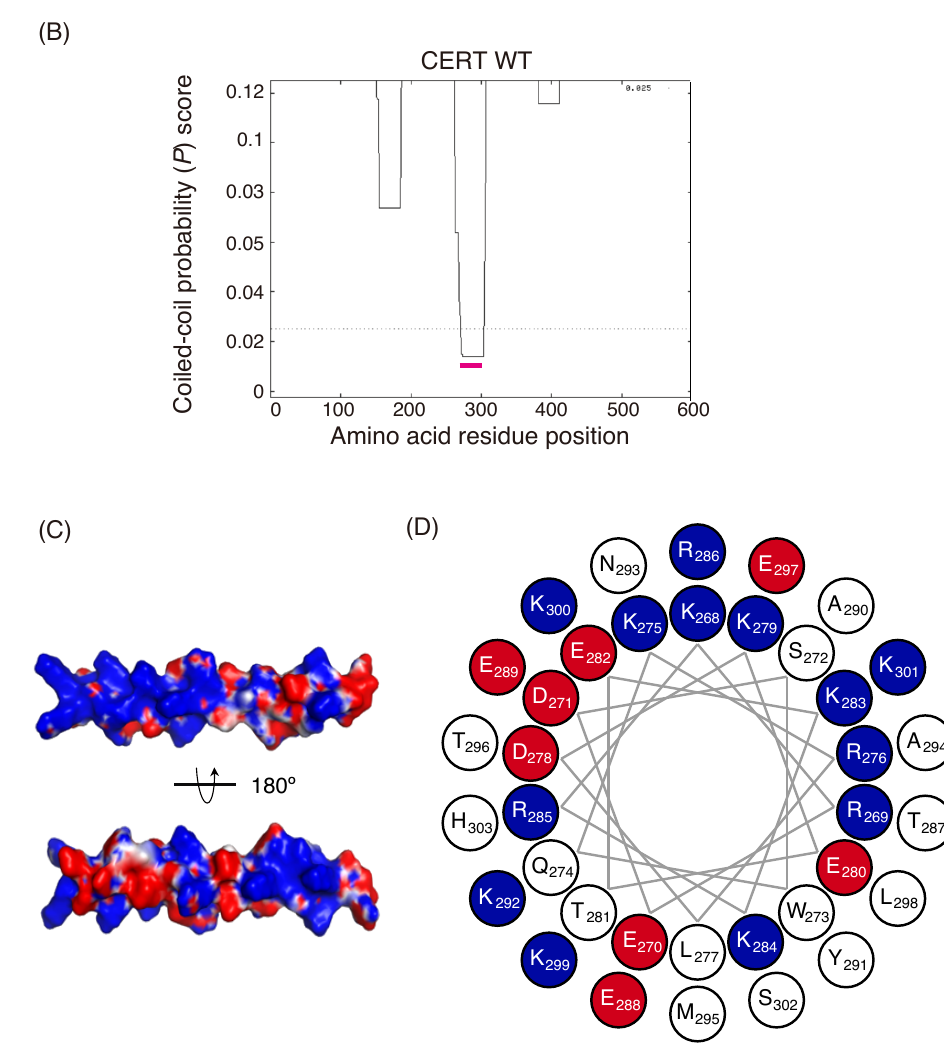
Figure 1. Identification of a putative coiled-coil region in CERT. ( A ) Domains and motifs of CERT. Amino acid sequences are specified for the SRM and CCR in wild-type (WT) and mutants that were used in this study. ( B ) Prediction of coiled-coil regions (CCRs) in CERT. The amino acid residues 268–303 of human CERT (highlighted with a magenta line) were predicted to be in a coiled-coil structure. The Paircoil2 program [20] was used to make the predictions. The decision threshold was set to 0.025 (dashed line), and a sliding window of 21 was used. ( C ) Three-dimensional protein modeling of the CCR in human CERT. CCBuilder 2.0 [21] was used for protein modeling, and PyMol (https://pymol.org/2/ accessed on 14 July 2018) was used to visualize charged surfaces. Basic and acidic amino acid residues are colored in blue and red, respectively. Other residues are colored in white. ( D ) Wheel model of the CCR from wild-type CERT. Lysine/arginine and glutamic acid/aspartic acid are colored in blue and red, respectively. ORIGAMI program [22] was used for wheel model